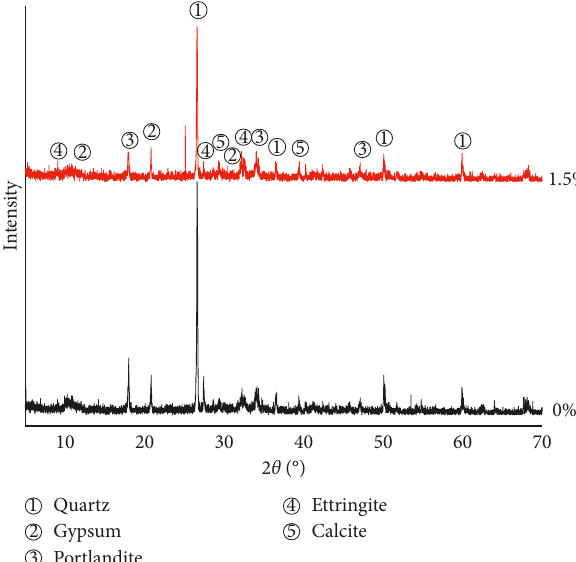
Figure 16: Linear expansion rate of mortars with different amounts of sodium sulfate.